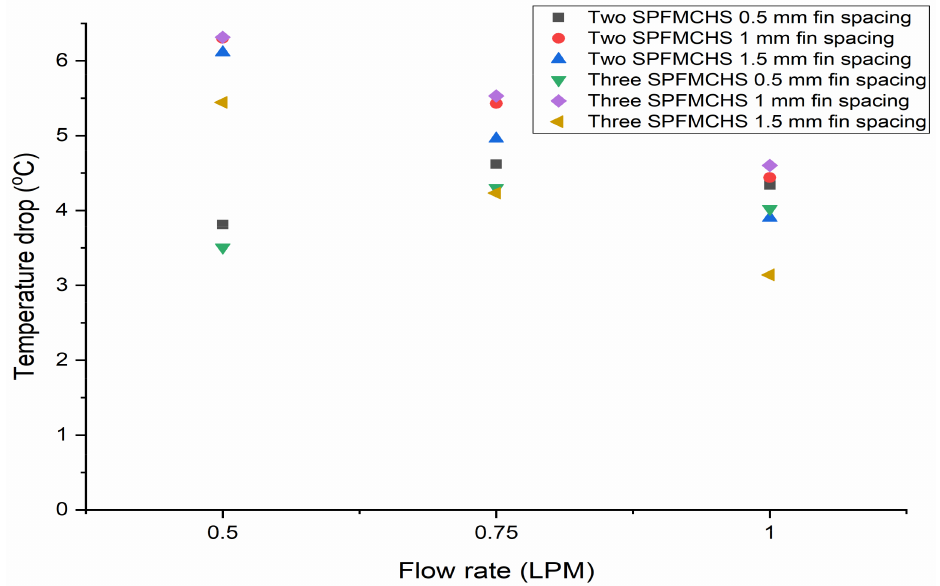
Figure 12. Temperature drop with volumetric flow